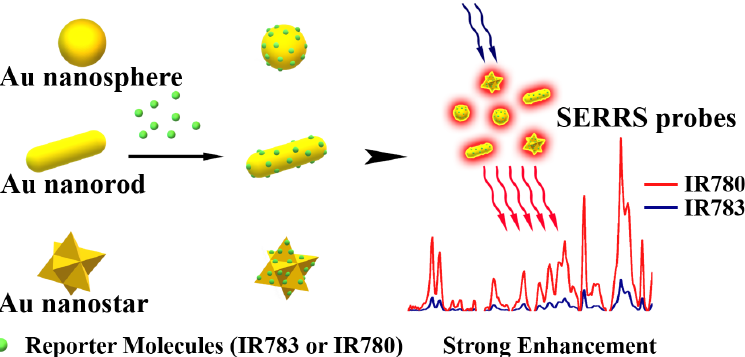
Fig. 1. Heptamethine cyanine based reporter molecule remarkably enhances SERRS signal intensity of gold nanoprobes.